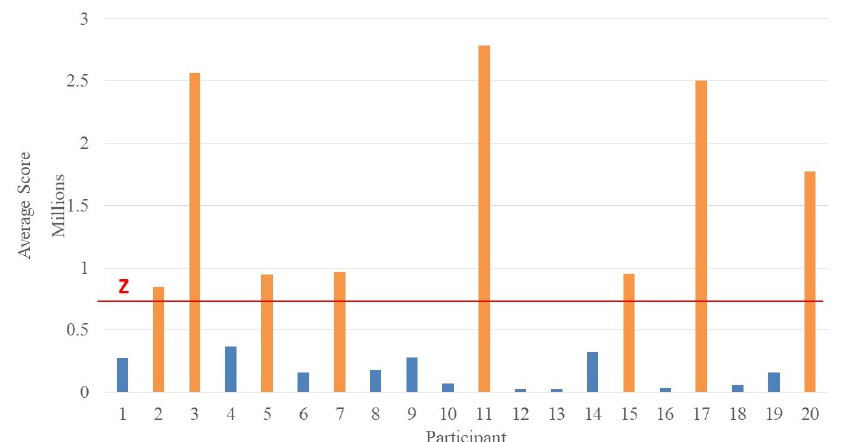
Figure 4. The average score of players and the threshold value for the players as novice or expert. The horizontal solid line shows the threshold value calculated using Equation